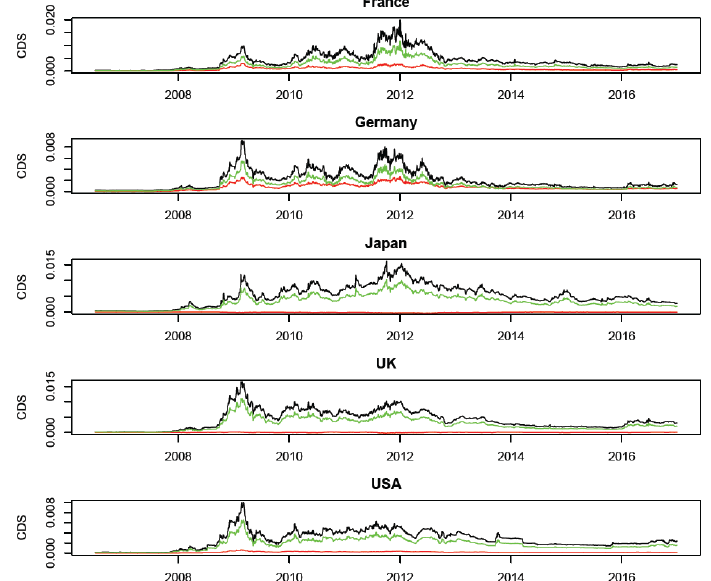
Figure 4. CoRisk and Total Risk for core countries. For each considered core country, the graphs report the observed CDS spreads (black line), the estimated autoregressive CDS spread components (green line) and the estimated contemporary CDS spread component ( CoRisk , red